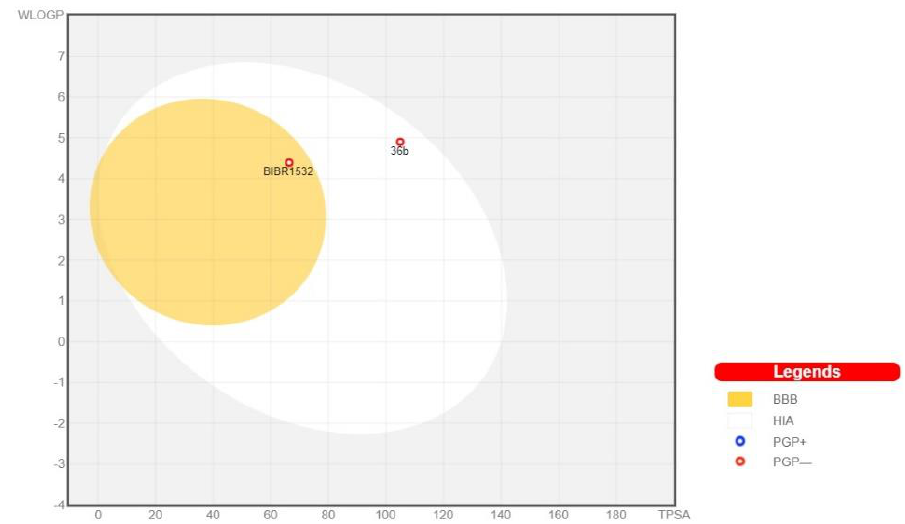
Figure 9. Predicted BOILED-Egg for both compound 36b and BIBR1532 . BBB (blood–brain barrier), HIA (human intestinal absorption), PGP+ (P-glycoprotein substrate), PGP − (not P-glycoprotein substrate).